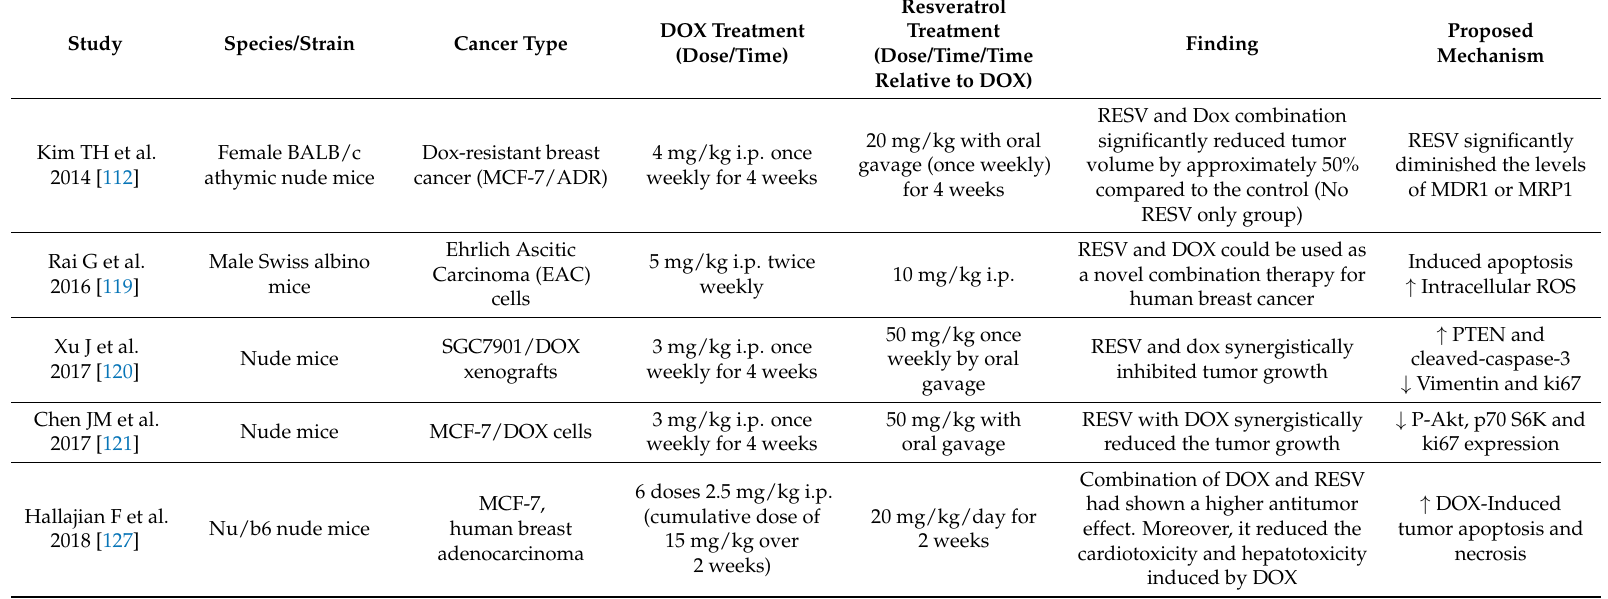
Table 4. In vivo studies demonstrating anticancer effect of resveratrol co-administration with